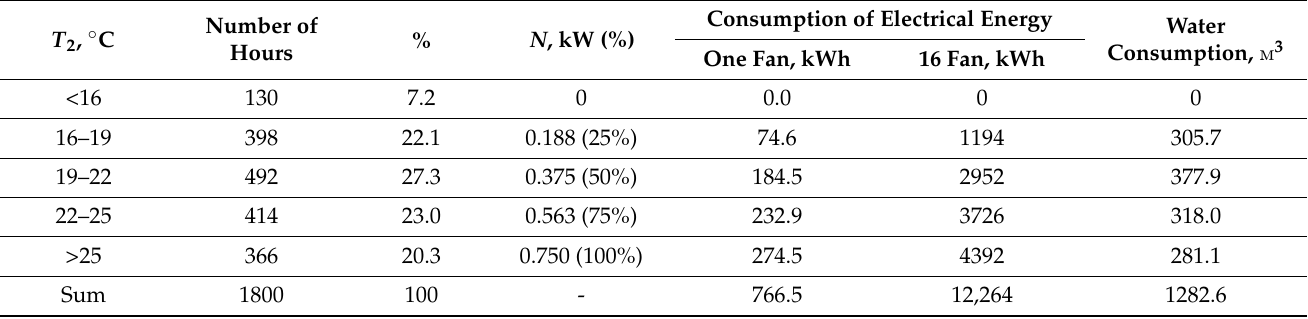
Table 3. Analysis of energy costs of the cooling system when regulated by using temperature.